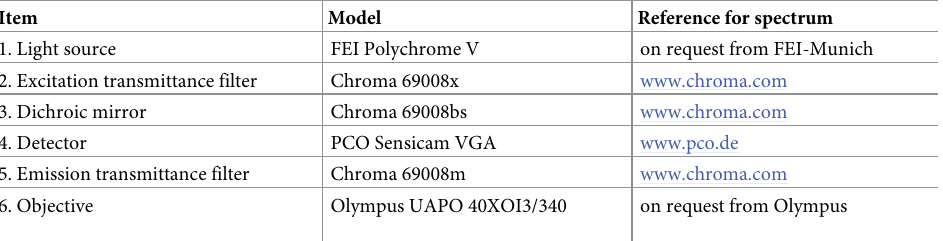
Table 1. Reference data on optical elements of the imaging